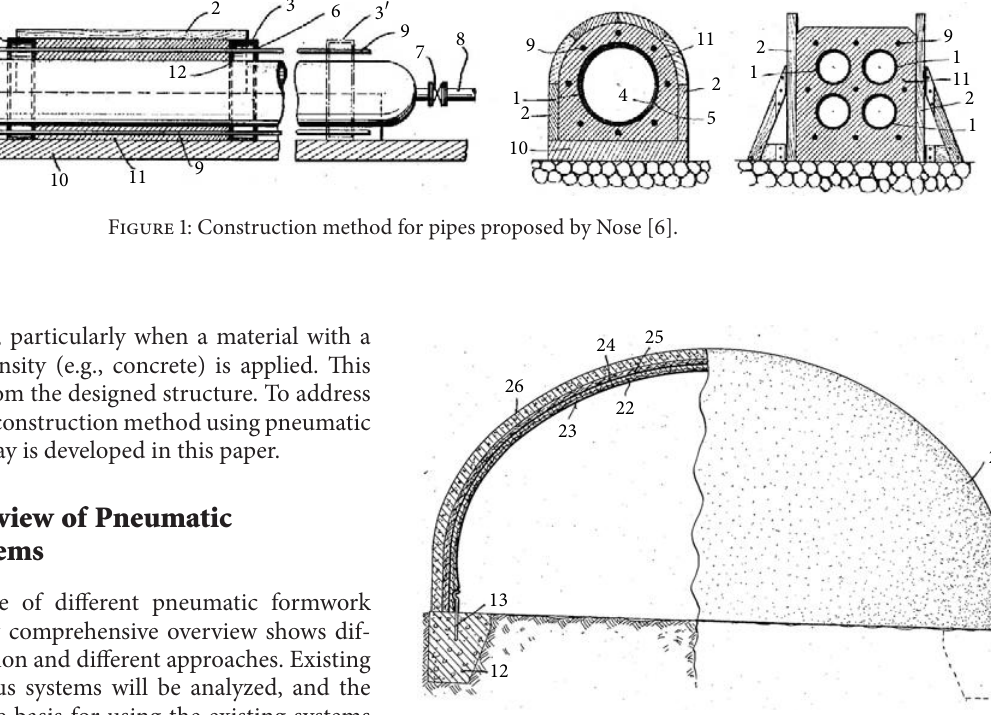
Figure 2: Concept drawing by Neff for the construction of concrete shells [7].